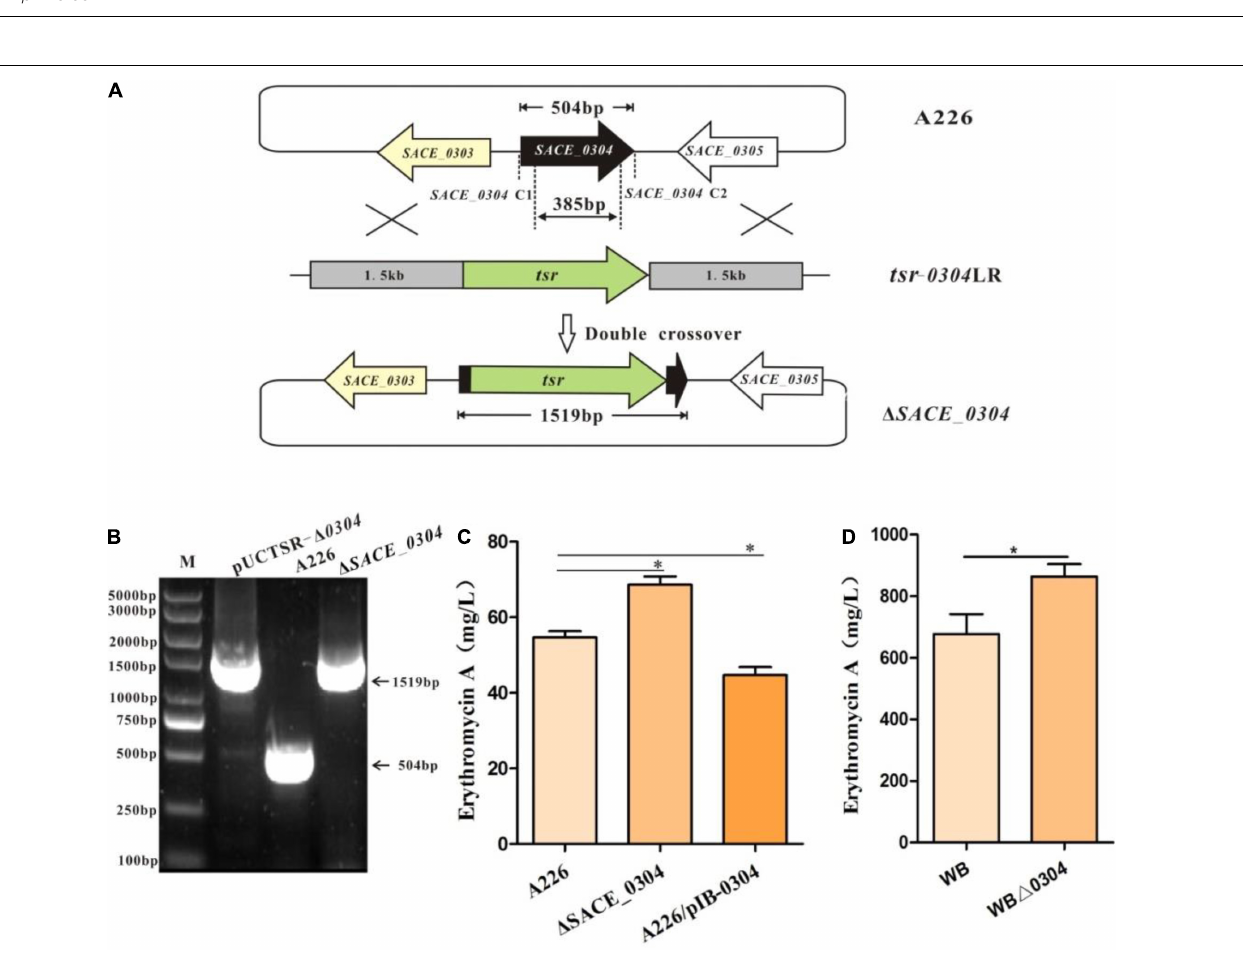
FIGURE 3 | Inactivation of SACE_0304 in Sac. erythraea . (A) Schematic deletion of SACE_0304 by linearized fragment homologous recombination in A226. (B) PCR confirmation of the SACE_0304 deletion mutant by the primers SACE_0304-C1 and SACE_0304-C2. The size of gene 504 bp amplified by PCR bands observed in A226, 1,519 bp was detected from pUCTSR- (cid:49) 0304 and (cid:49) SACE_0304 . (C) Er-A yields in A226, (cid:49) SACE_0304 and A226/pIB-0304. (D) Er-A yields in WB and WB (cid:49) 0304 . Error bars (C,D) : SD from triplicate experiments. Statistical notations (C,D) : ∗ p < 0.05.